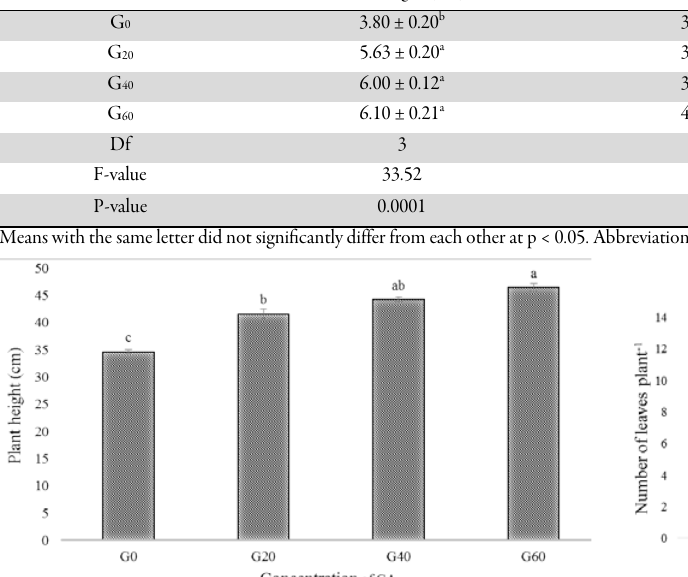
Table 2. The influence of various doses of GA 3 on root length, bulb length and bulb diameter at harvest time in onion Factors